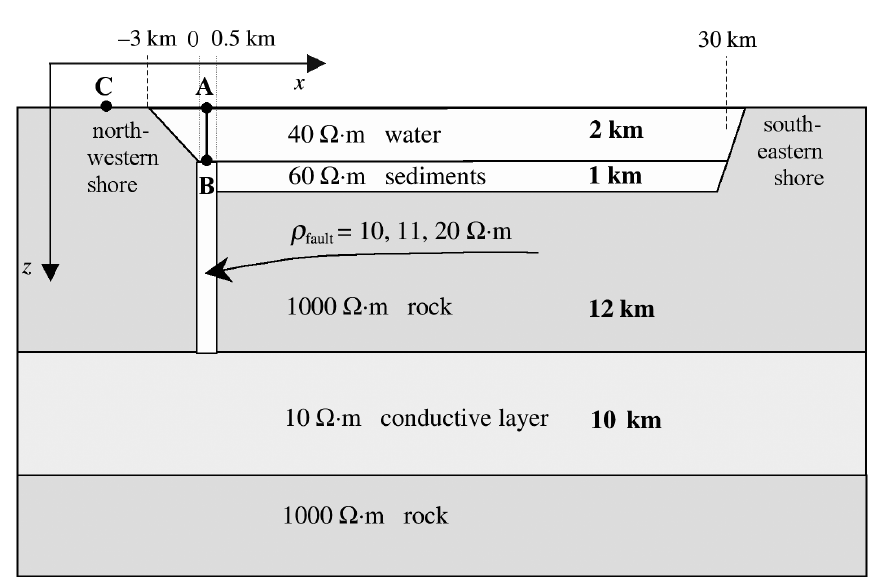
Fig. 2. 3D resistivity model of the Baikal Fault (side view). Line A - B is the profile where behaviour of E z is studied. C is the coast site where components H x and H y are taken to obtain E z response (see details in the text).